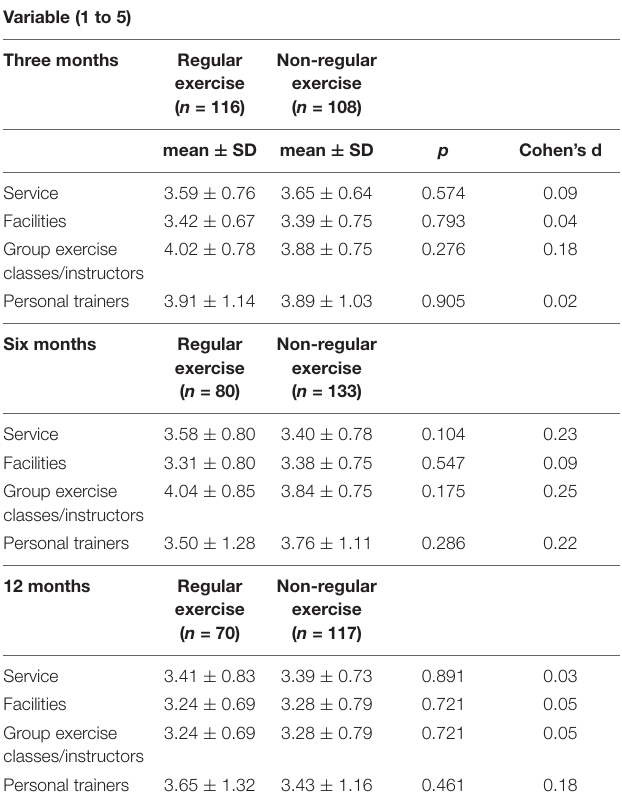
TABLE 4 | Customer satisfaction at the fitness